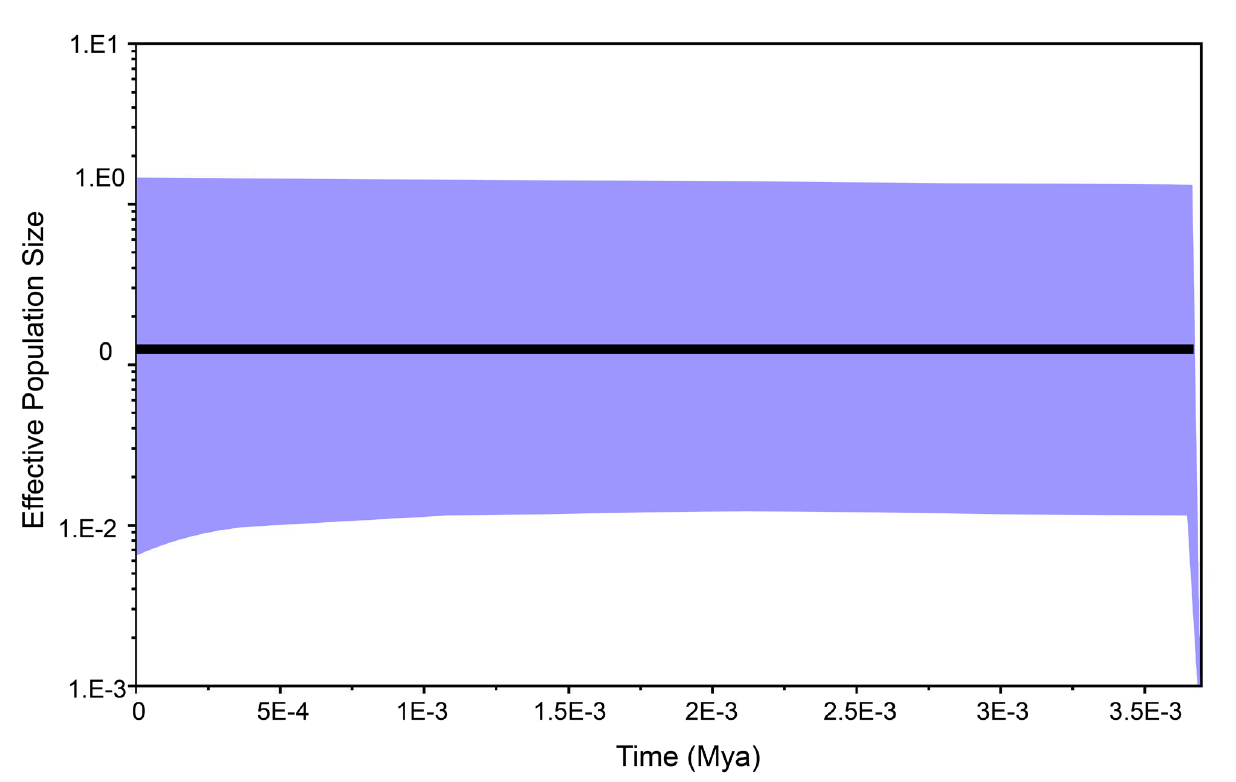
FIGURE 6 | Bayesian skyline plot showing the effective population size fluctuation of Acyrtus simon through time (Mya) (black line: median estimation; purple: confidence